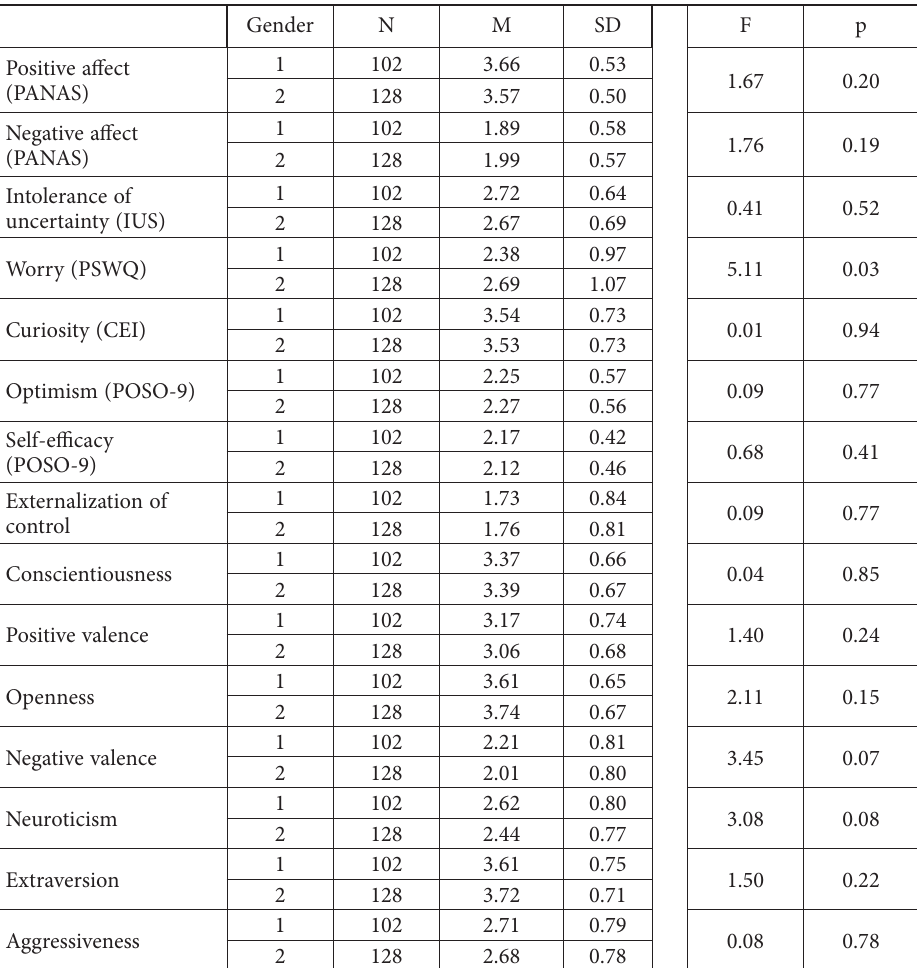
Table 3. Multivariate analysis of variance (MANOVA): testing differences by gender Gender N M SD F p